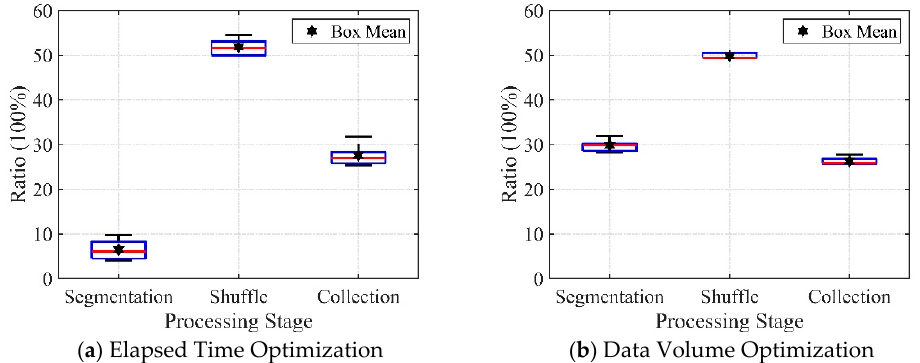
Figure 12. The improvement ratio of the elapsed time and data volume transmission in our strategy. Table 7. The data volume variations during in different processing stages.